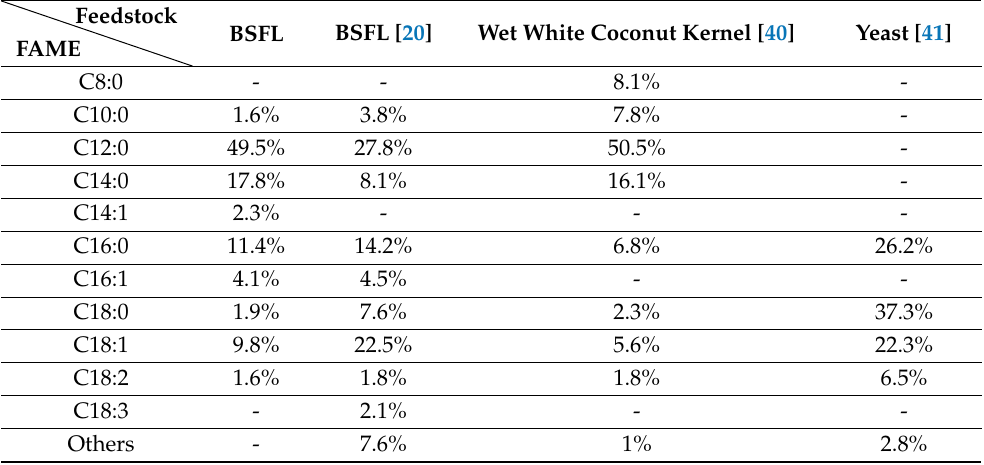
Table 1. Comparison of FAME compositions between BSFL with other